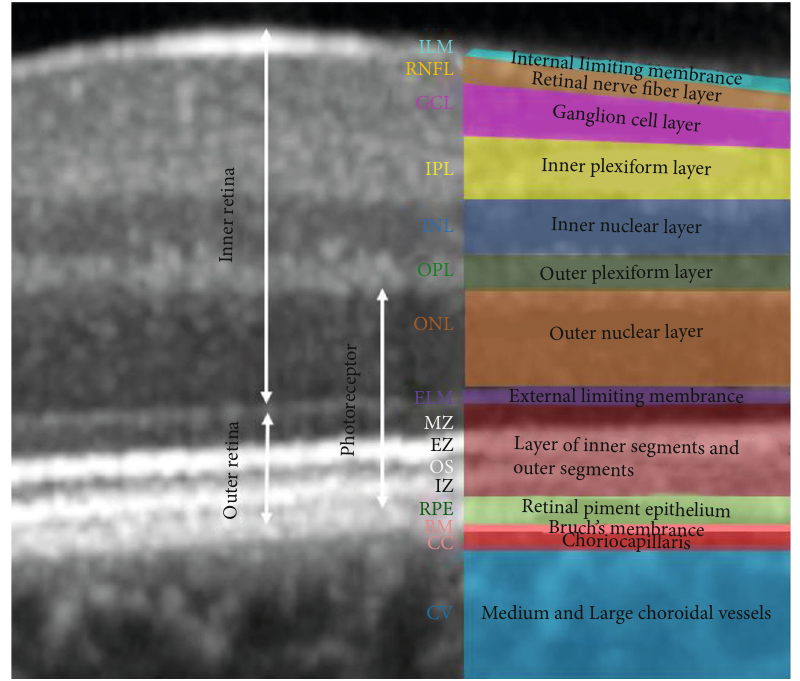
Figure 2: Retinal layer